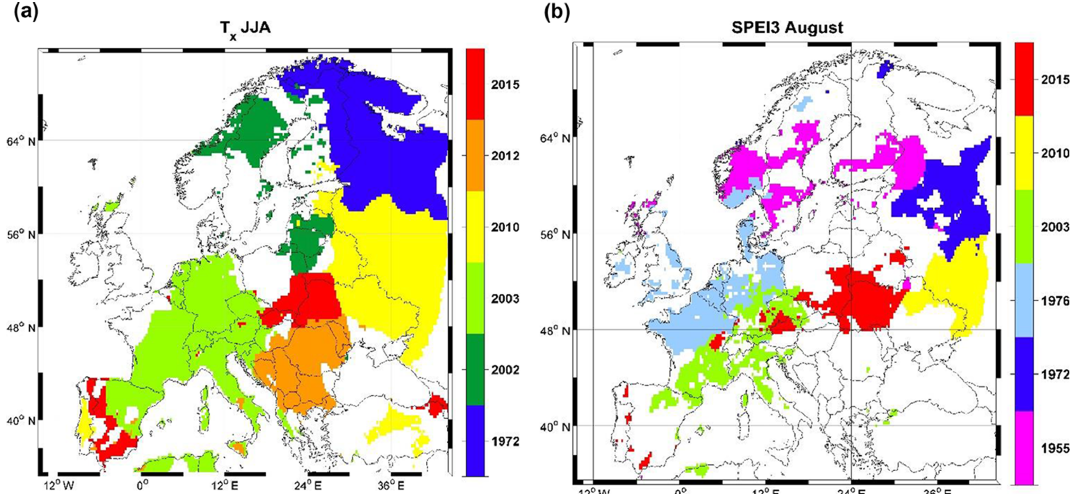
Figure 9. (a) The spatial extent and the year of record of the warmest summers ( T x JJA) over the last 66 years over Europe; (b) is the same as in (a) but for the driest years (SPEI3). Analyzed period: